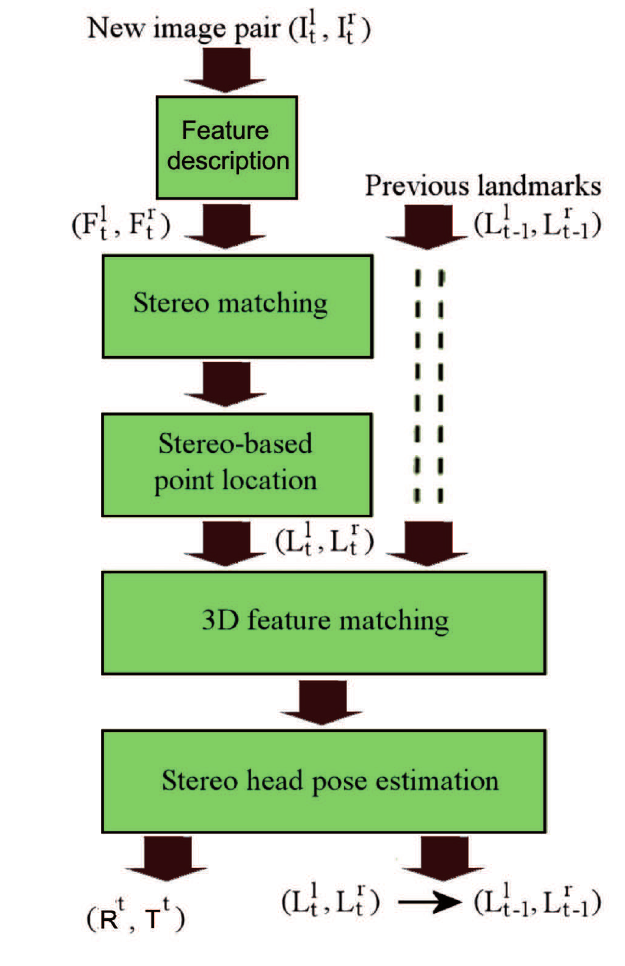
Figure 2. Overview of the proposed visual odometry